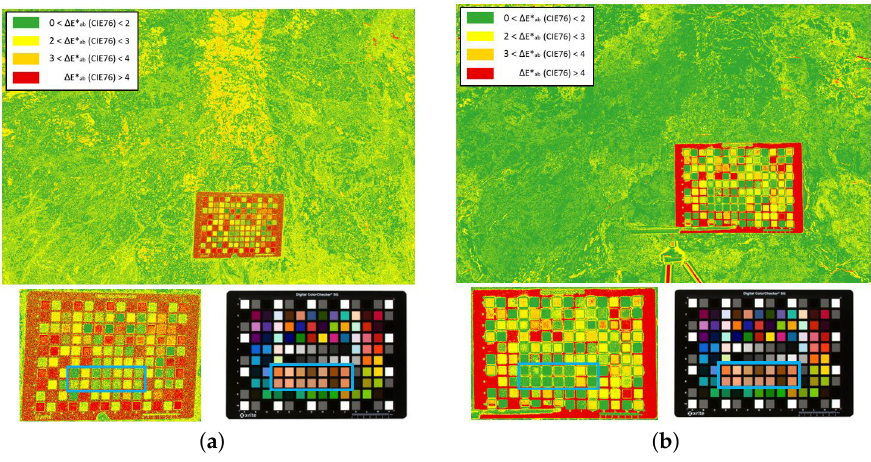
Figure 9. ∆ E ∗ difference mapping images between GP and second-order polynomial characterization ab models: ( a ) Sigma SD15; ( b ) Fujifilm IS PRO.